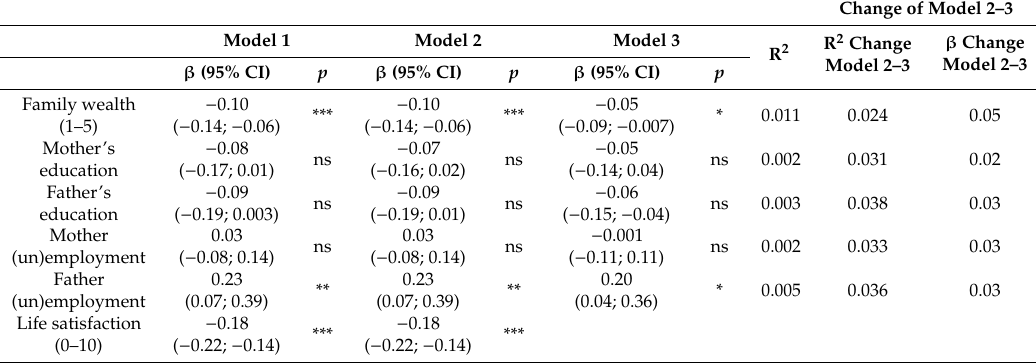
Table 3. Associations between socioeconomic situation, life satisfaction, and potential confounders with degree of excessive Internet use, linear regression model adjusted for gender and age (2844 Slovak adolescents aged 13–15 years old, HBSC study